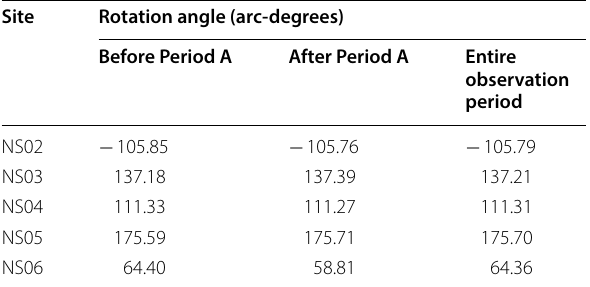
Table 1 Estimation of the horizontal rotation angle, θ , to convert the coordinate system azimuth into a geographical